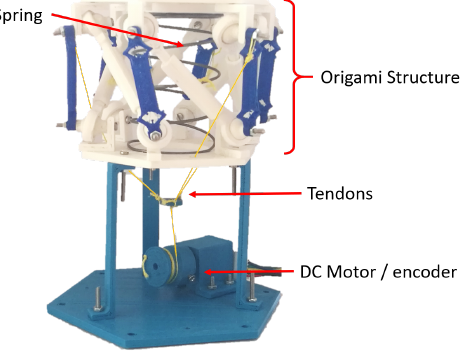
Figure 9. Cable-driven single link prototype.